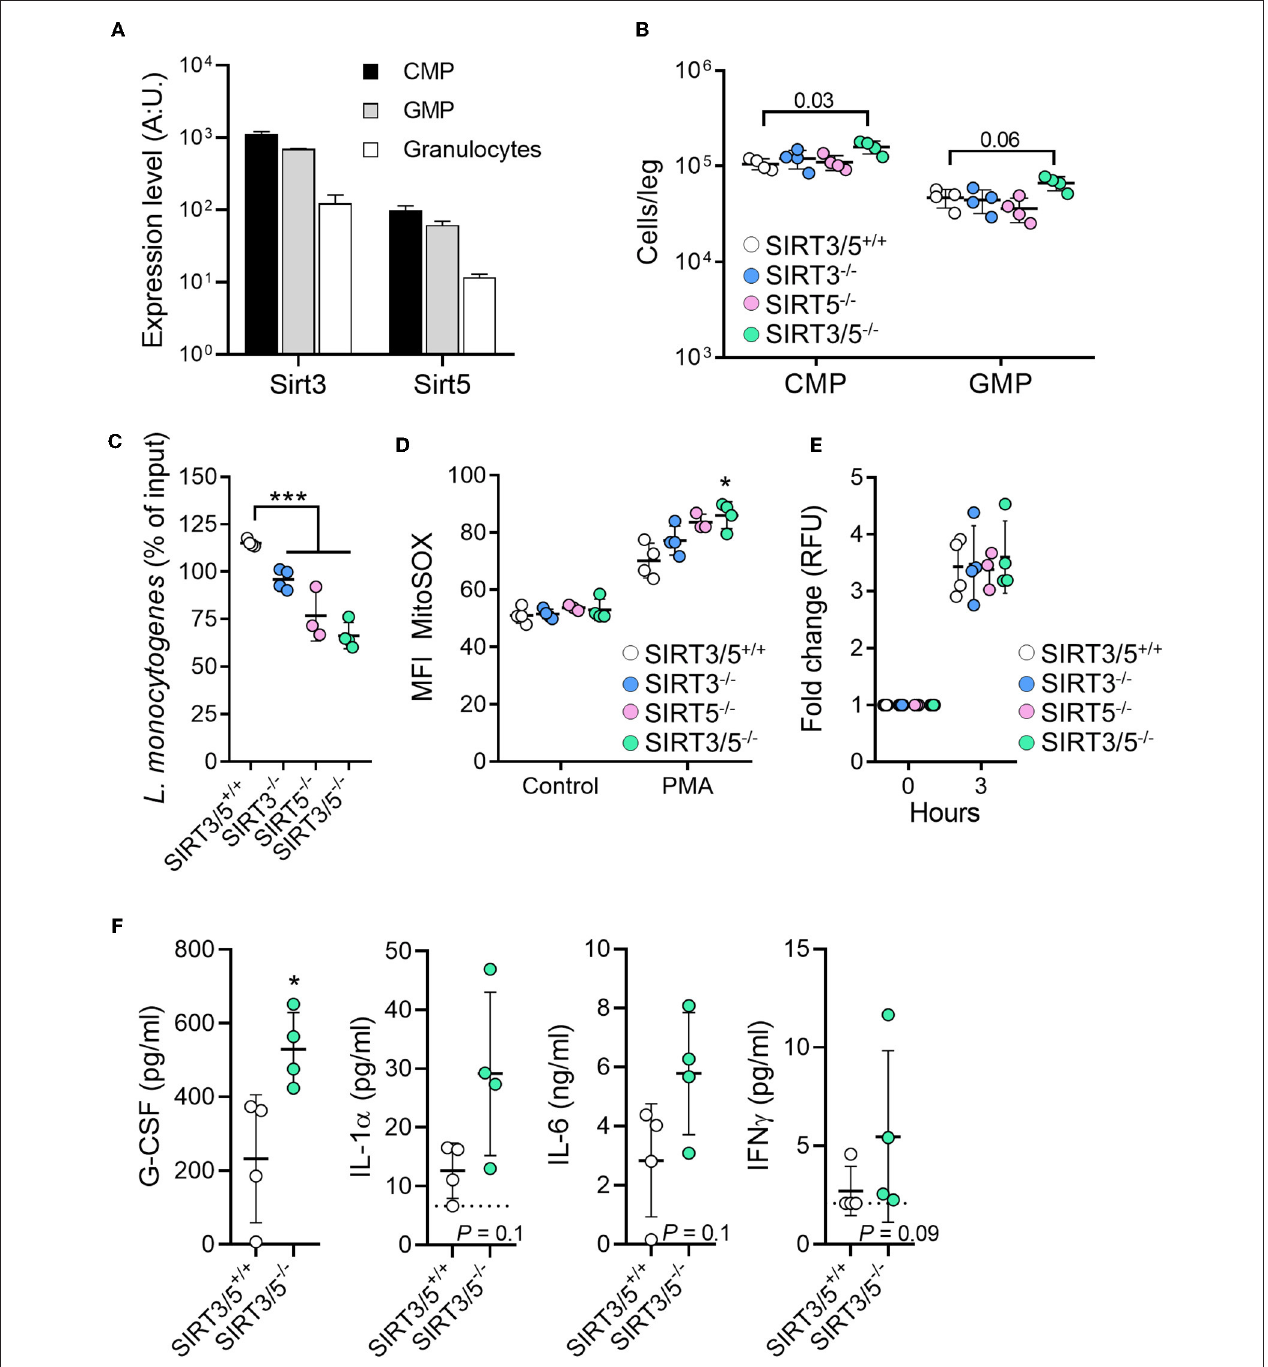
FIGURE 4 | Increased killing of Listeria monocytogenes by SIRT3/5 deficient neutrophils. (A) Sirt3 and Sirt5 mRNA expression levels in common myeloid progenitors (CMP), granulocyte-monocyte progenitor (GMP), and granulocytes. Data were extracted from BioGPS (http://biogps.org). (B) Number of CMP (Lin − c-kit + CD34 + cells) and GMP (Lin − c-kit + CD135 + CD34 + cells) per leg of SIRT3/5 + / + , SIRT3 − / − , SIRT5 − / − , and SIRT3/5 − / − mice aged 8–9 weeks. The gating strategies are presented in Supplementary Figure S2. (C–E) Killing of bacteria (C) and production of mtROS (D) and NETs (E) by neutrophils. Neutrophils were incubated for 1h with L. monocytogenes (0.1 cfu/cell) (C) , for 50min with PMA (100nM) and MitoSOX (D) or for 3h with PMA (100nM) and SYTOX (E) . Bacteria were enumerated and results expressed relative to the initial inoculum set at 100% (C) . * P < 0.05; *** P < 0.005. (F) G-CSF, IL-1 α , IL-6, and IFN γ concentrations, determined by Luminex, in blood from SIRT3/5 + / + and SIRT3/5 − / − mice incubated with heat-killed L. monocytogenes for 24h. The concentrations of CCL2, CCL3, CXCL1, CXCL5, CXCL10, IL-1 β , IL-10, IL-12p40, IL-17A, IL-18 and TNF were similar for SIRT3/5 + / + and SIRT3/5 − / − blood.